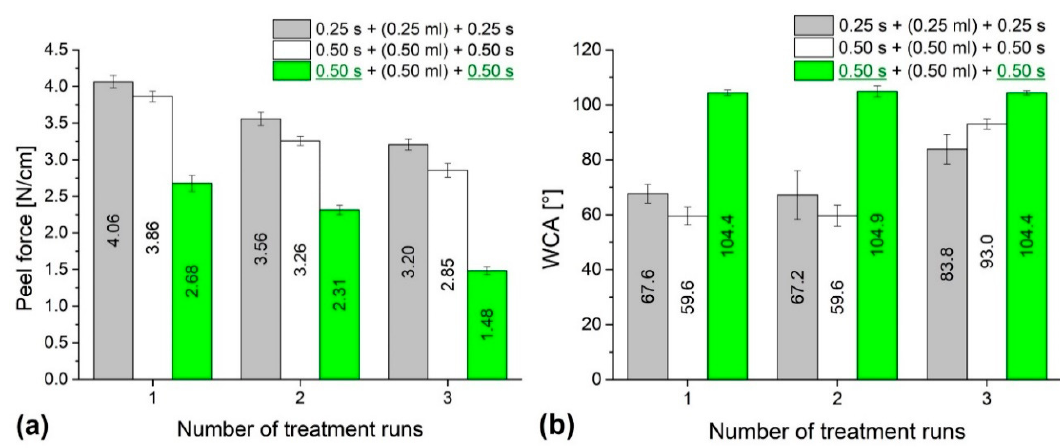
Figure 3. Graphs depicting peel force and WCA values ( a ) and stability and aging of the coating ( b ) measured on silicone-coated paper dependent on the pretreatment time with the post-treatment in nitrogen. The treatment in nitrogen is underlined and labeled by green color.